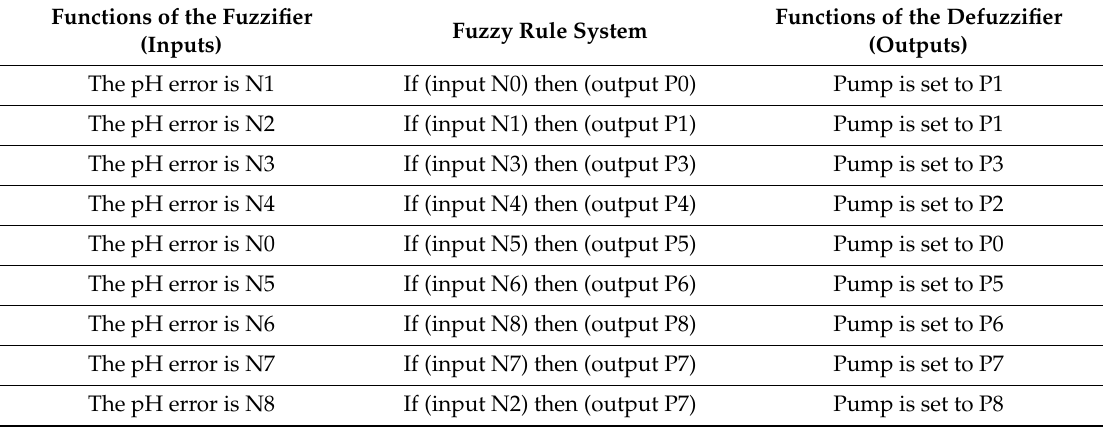
Table A2. Input and output functions with fuzzy system rules.